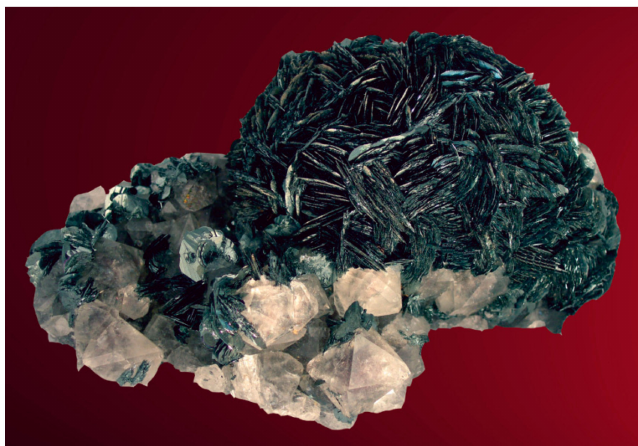
Figure 14. Hematite and quartz, Chub Lake prospect. 9 cm. Chamberlain Collection, NYSM C9492. SC.